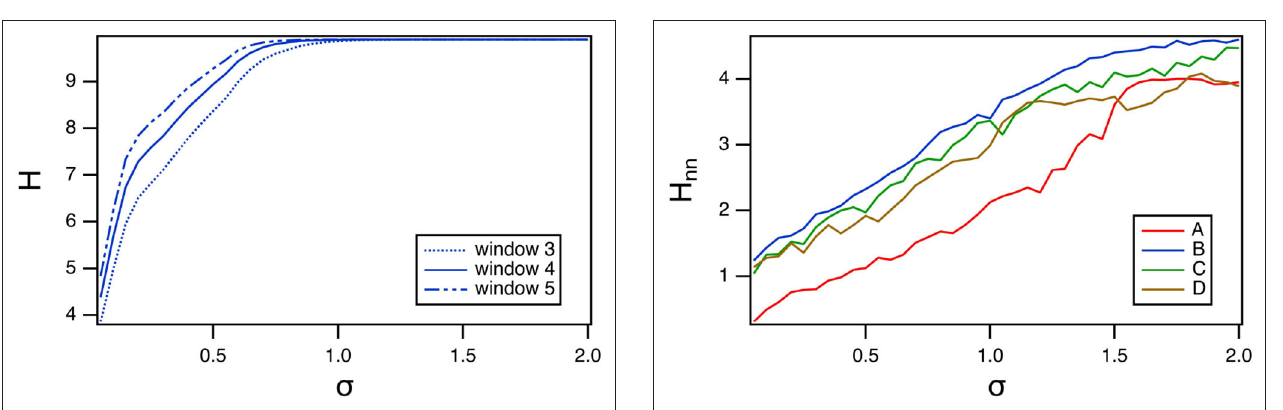
FIGURE 11 | Permutation entropy H as a function of the spectral radius σ for the polynomial ODE reservoir computer driven by Sprott system B, as the window length varies. For this plot, p 1 = − 0.5 and the time constant T 0 = 0.3.